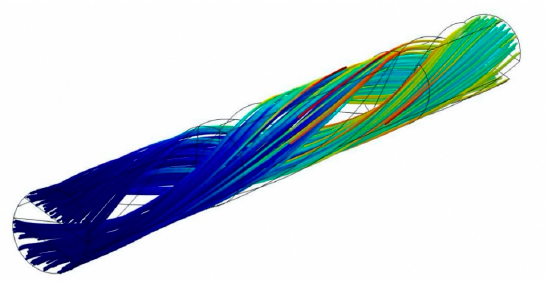
Figure 7. Flow structure with the twisted tape insert.